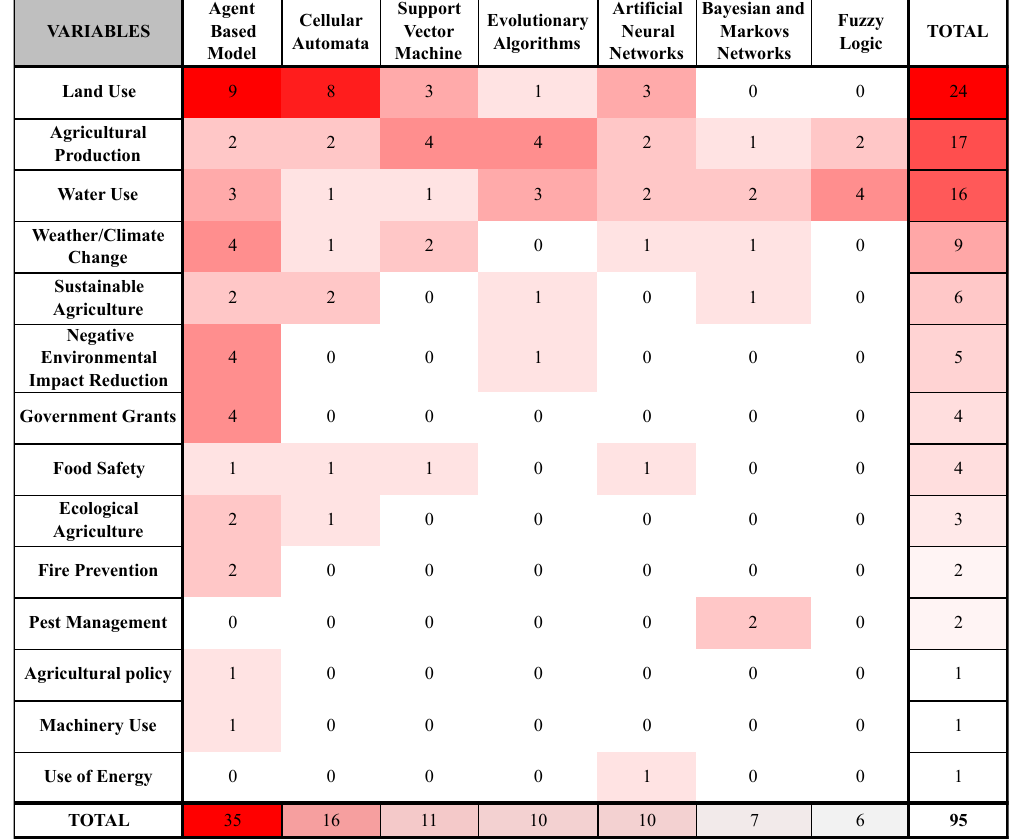
Figure 3. Agricultural public policy variables and artificial intelligence